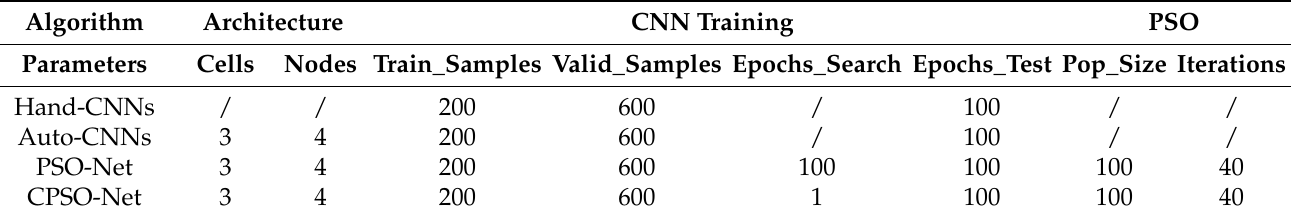
Table 2. Experimental settings for the different methods. CNN, convolutional neural network. Algorithm Architecture CNN Training